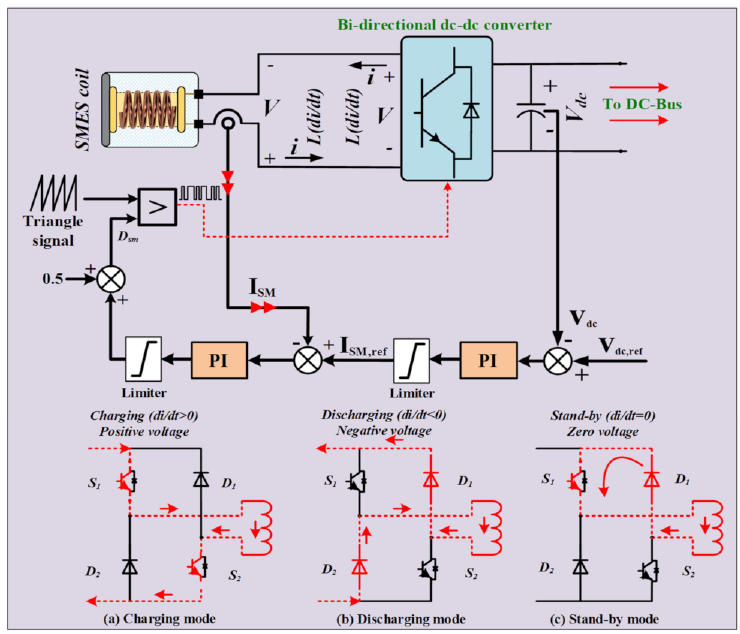
Figure 7. The SMES control modes: ( a ) charging mode, ( b ) discharging mode, and ( c ) stand-by